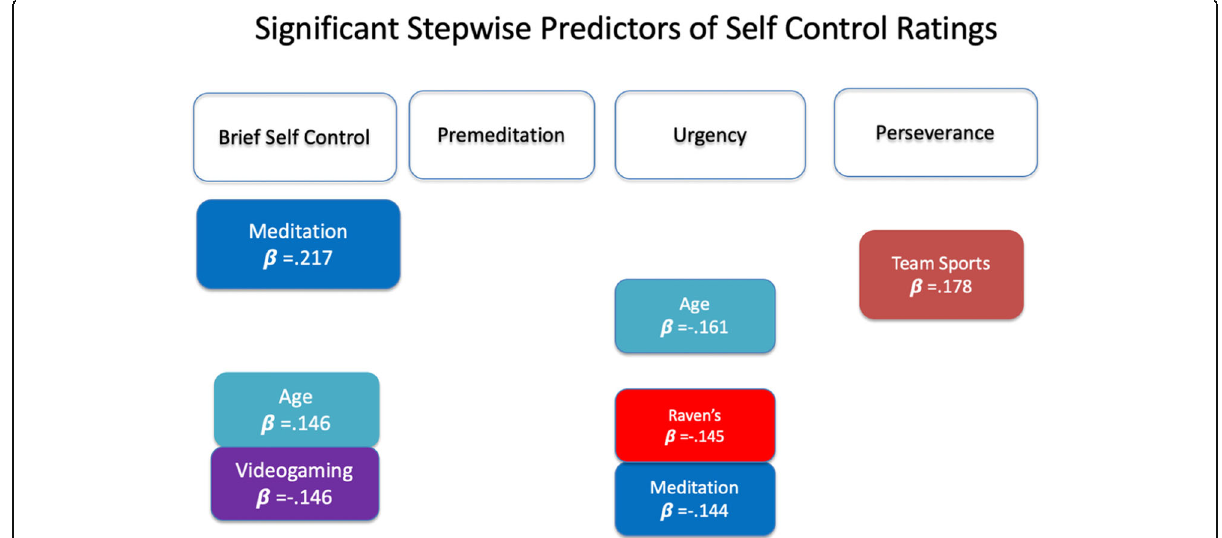
Fig. 4 Significant predictors with their beta coefficients for the stepwise regression analyses on the self-control scores for each of the four